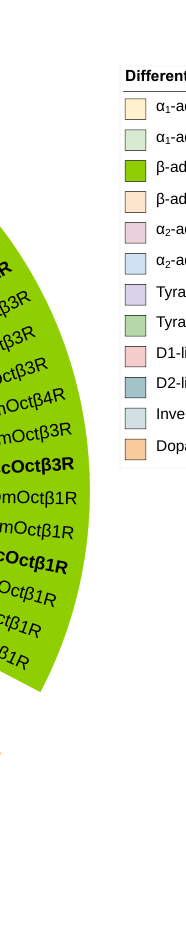
Figure 1. Phylogenetic relationship of CcOct β Rs and various biogenic amine receptors. MEGA 7.0 software was used to construct the neighbor-joining tree. Drosophila ninaE rhodopsin 1 (CG4550) and FMRFamide receptor (CG2114) were used as outgroups. CcOct β Rs are in bold. The accession numbers of amino acid sequences used in the phylogenetic analysis were indicated in Supplementary Table S1. Abbreviations: Am, Apis mellifera ; Dm, Drosophila melanogaster ; Tc, Tribolium castaneum ; Cs, Chilo suppressalis ; Nl, Nilaparvata lugens ; Hs, Homo sapiens ; Pc, Priapulus caudatus ; Pd, Priapulus caudatus ; Sk, Saccoglossus kowalevskii . Hs and Sk are deuterostomian species, and the others are protostomian